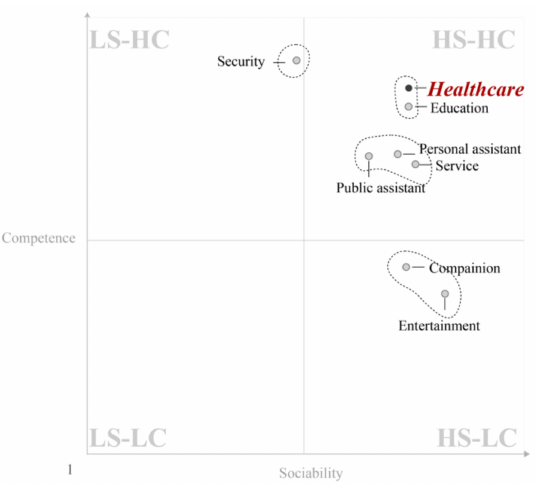
Figure 1. User expectation coordinate system for robot